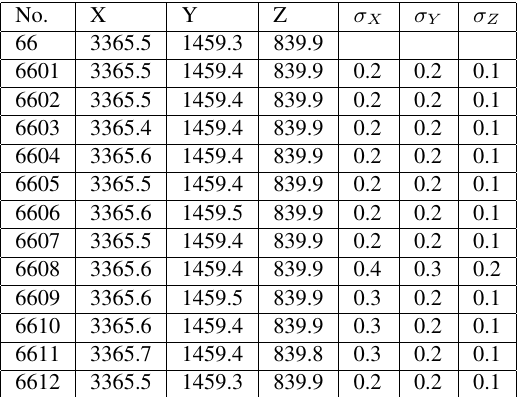
Table 6: Results of test 3: Results of spatial forward section using one image pair of each camera “cam 1” to “cam 12” in mm . Point 66 is the true value. The points 66 ij result from camera “cam ij” (all coordinates in mm ).